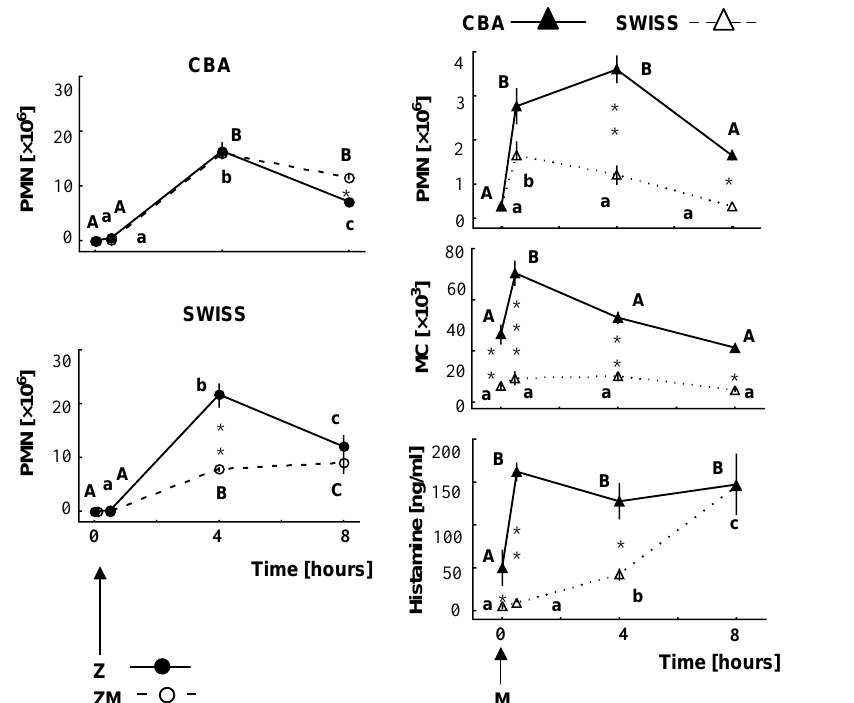
FIG. 1. Comparison of early stages of peritonitis in males of CBA and SWISS mice intraperitoneally injected with zymosan (Z group), zymosan supplemented with morphine (ZM group) or morphine only (M group). Numbers of peritoneal polymorpho- nuclear leukocytes (PMNs), mast cells (MC) or histamine levels at time 0 (controls) or 30 min, 4 h and 8 h after injection. Data presented as mean 9 / standard error (n (cid:5) / 4 (cid:1) / 6). Values with the same letter (e.g. ‘A’ and ‘A’, ‘b’ and ‘b’) do not differ significantly within the group, while values with different letters (e.g. ‘A’ versus ‘B’, ‘a’ versus ‘b’) vary significantly within the group at p B / 0.05. Values significantly different between the groups: *p B / 0.05, **p B / 0.01, ***p B / 0.001.